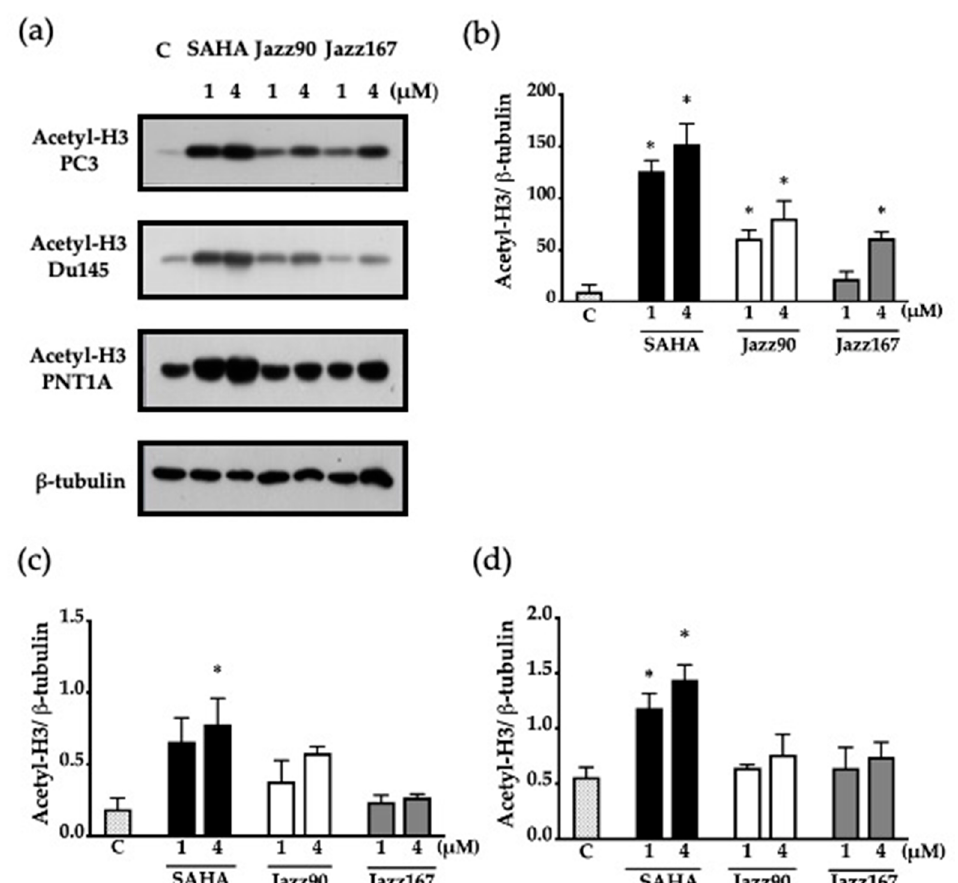
Figure 4. Acetylation levels of CRPC (PC3 and DU145) and normal prostate (PNT1A) cells after treatment at concentrations of 1 and 4 µM of SAHA, Jazz90 and Jazz167. Vehicle control cells (C) were treated with 0.5% DMSO. Cells were harvested 24 h after treatment. ( a ) Representative Western blots for acetyl-H3 and β -tubulin (loading control) are shown for each of the cell lines. Scanning densitometry of Western blots for ( b ) PC3, ( c ) DU145, and ( d ) PNT1A cells. Bars represent the mean ± S.E.M. from three independent experiments. Data were analyzed using one-way ANOVA followed by Bonferroni’s post hoc test; * indicates significant increases relative to the control, p < 0.05.